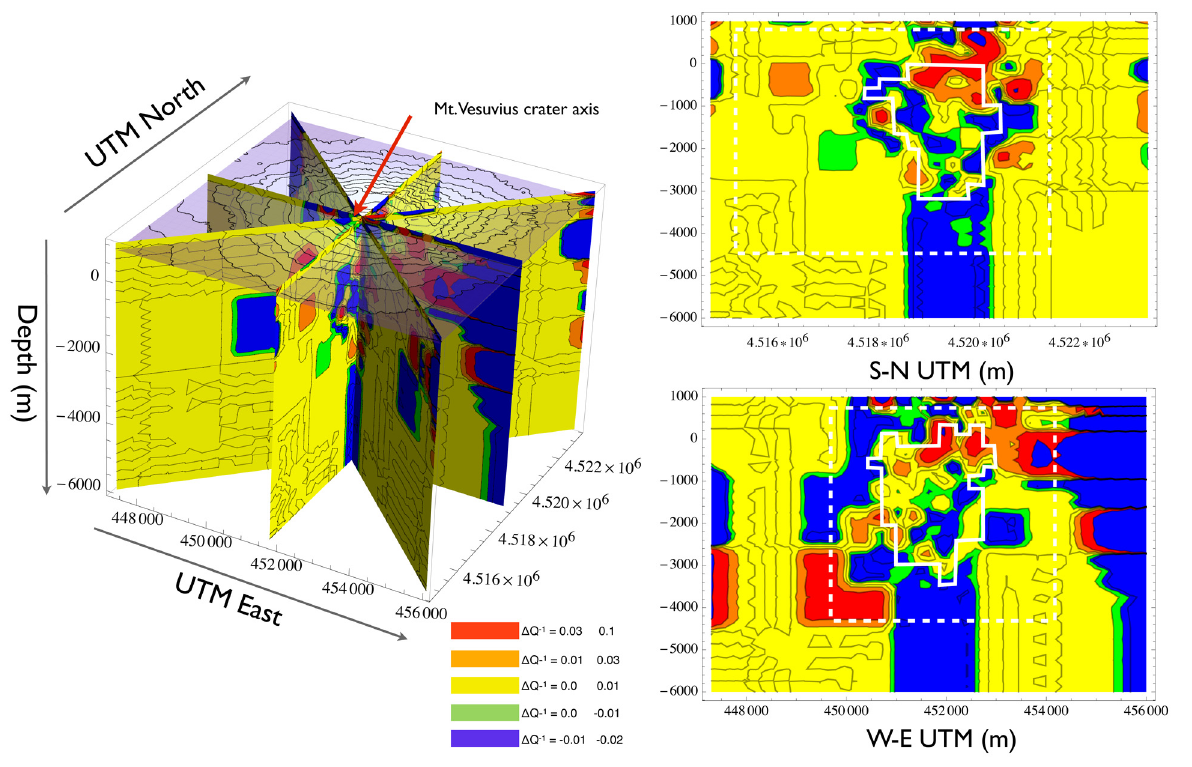
Figure 3. Left panel: 3D plot of the S-wave differential total-attenuation (total-Q - <total-Q>). Easting and Northing is in UTM (meters). Depth is negative below the sea level. Mt. Vesuvius map is plotted in transparency at 800 m a.s.l. Right panels: S-N (up) and W-E sections, displaced separately for better clarity. White dashed lines confine the zone with 1000 m resolution. Continuos line border the 500 m res- olution